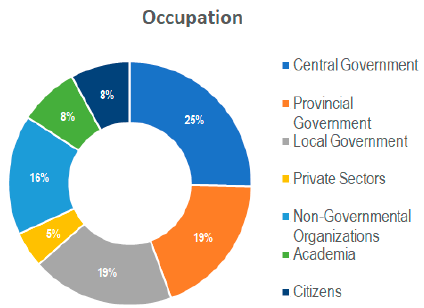
Figure 7. Respondents based on affiliation (sectors) .